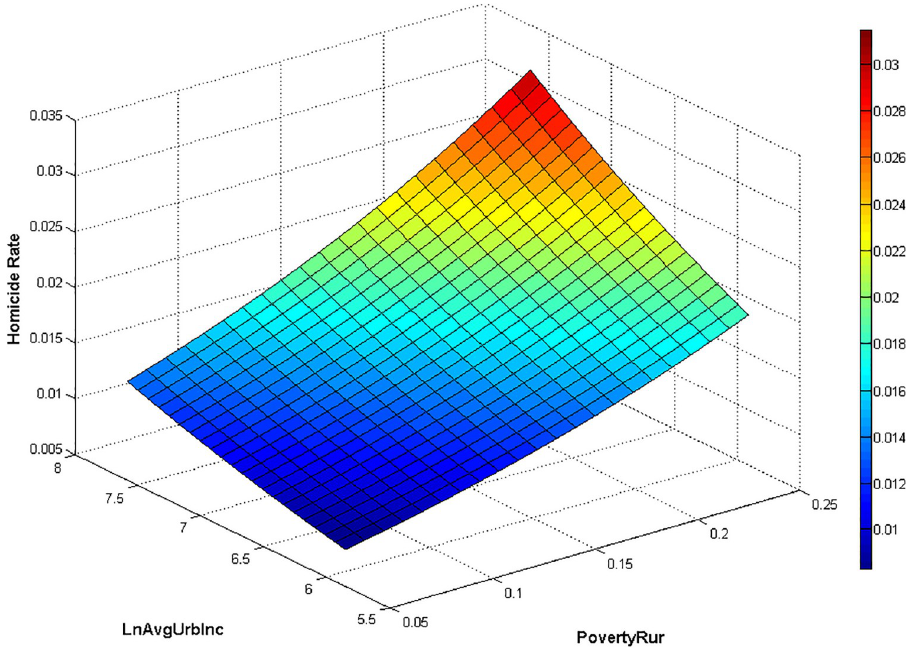
Fig 1. Predictions of homicide rate for the span of values of rural poverty and urban average income in the sample.